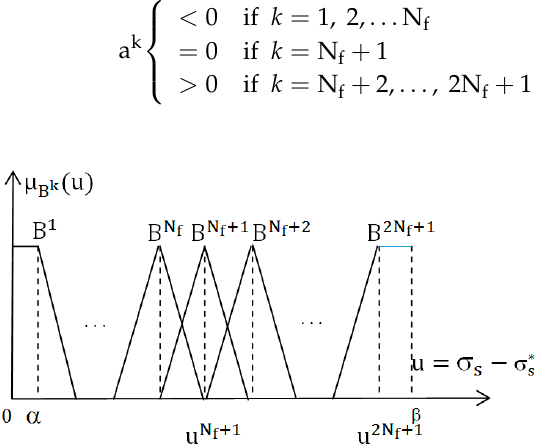
Figure 1. The membership function of the input.